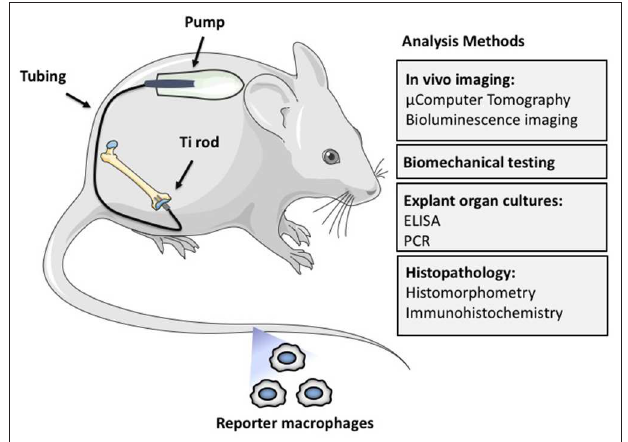
FIGURE 2 | The murine femoral continuous intramedullary particle infusion model. First, the osmotic pump is loaded with biomaterial wear debris and then implanted in the subcutaneous tissue at the dorsum of the mouse. The pump is then connected via subcutaneous tubing to a hollow titanium rod that has been press fit into the intramedullary canal of the distal femur. This arrangement facilitates continuous delivery of biomaterial wear debris to the intramedullary space for 28 days, resulting in continued low grade inflammation and bone loss. The particle delivery can be further extended by changing the pump in a minor surgery. The resulting bone loss at the distal femur can be quantified by imaging techniques such as µ CT, biomechanical testing of the peri-implant bone, and histomorphometry. The chronic inflammatory reaction can be quantified by analysis of femoral explant cultures and various histopathological techniques including identification of specific cell populations and their activation states by immunohistochemistry. Finally, systemic homing of macrophages and other cells to the area of inflammation can be quantified by utilizing luciferase labeled reporter macrophages that are injected into the circulation via the tail vein. Adding biologics to the pump with the particles allows the study of potential therapeutic effects of different locally infused